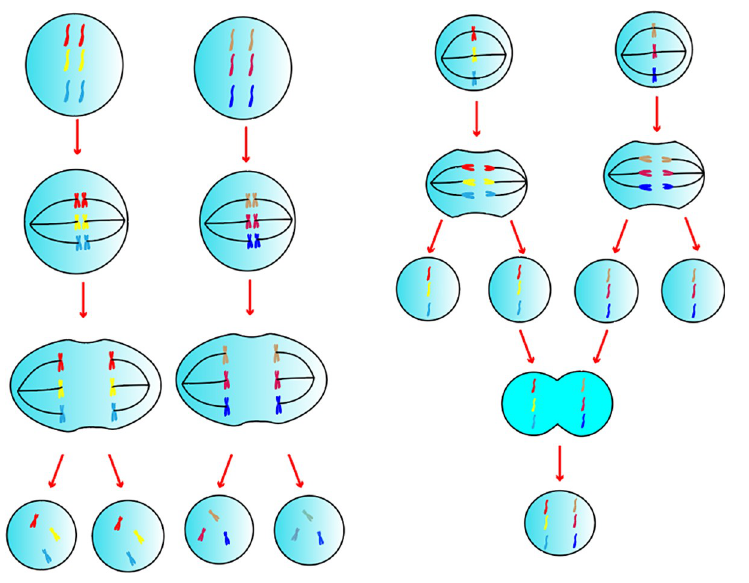
Fig 5. Meiotic fusion